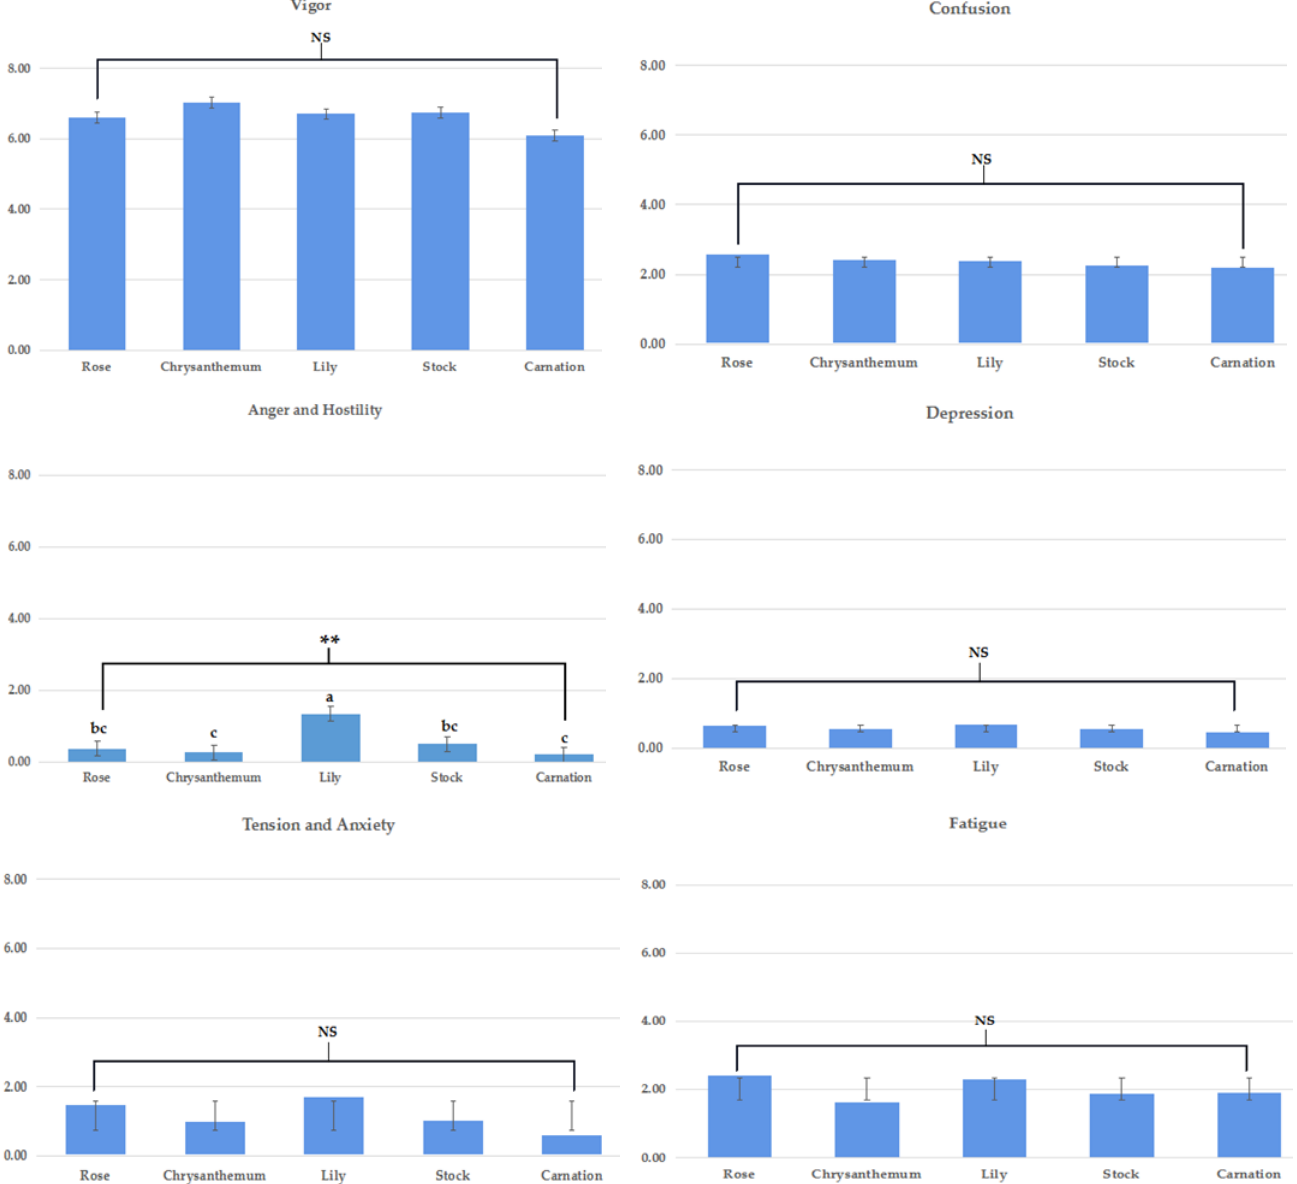
Figure 6. The results of profile of mood state (POMS) are divided into six indicators: Vigor, confusion, anger and hostility, depression, tension and anxiety, fatigue (NS = no significant difference, ** is p < 0.01, a > b > c).